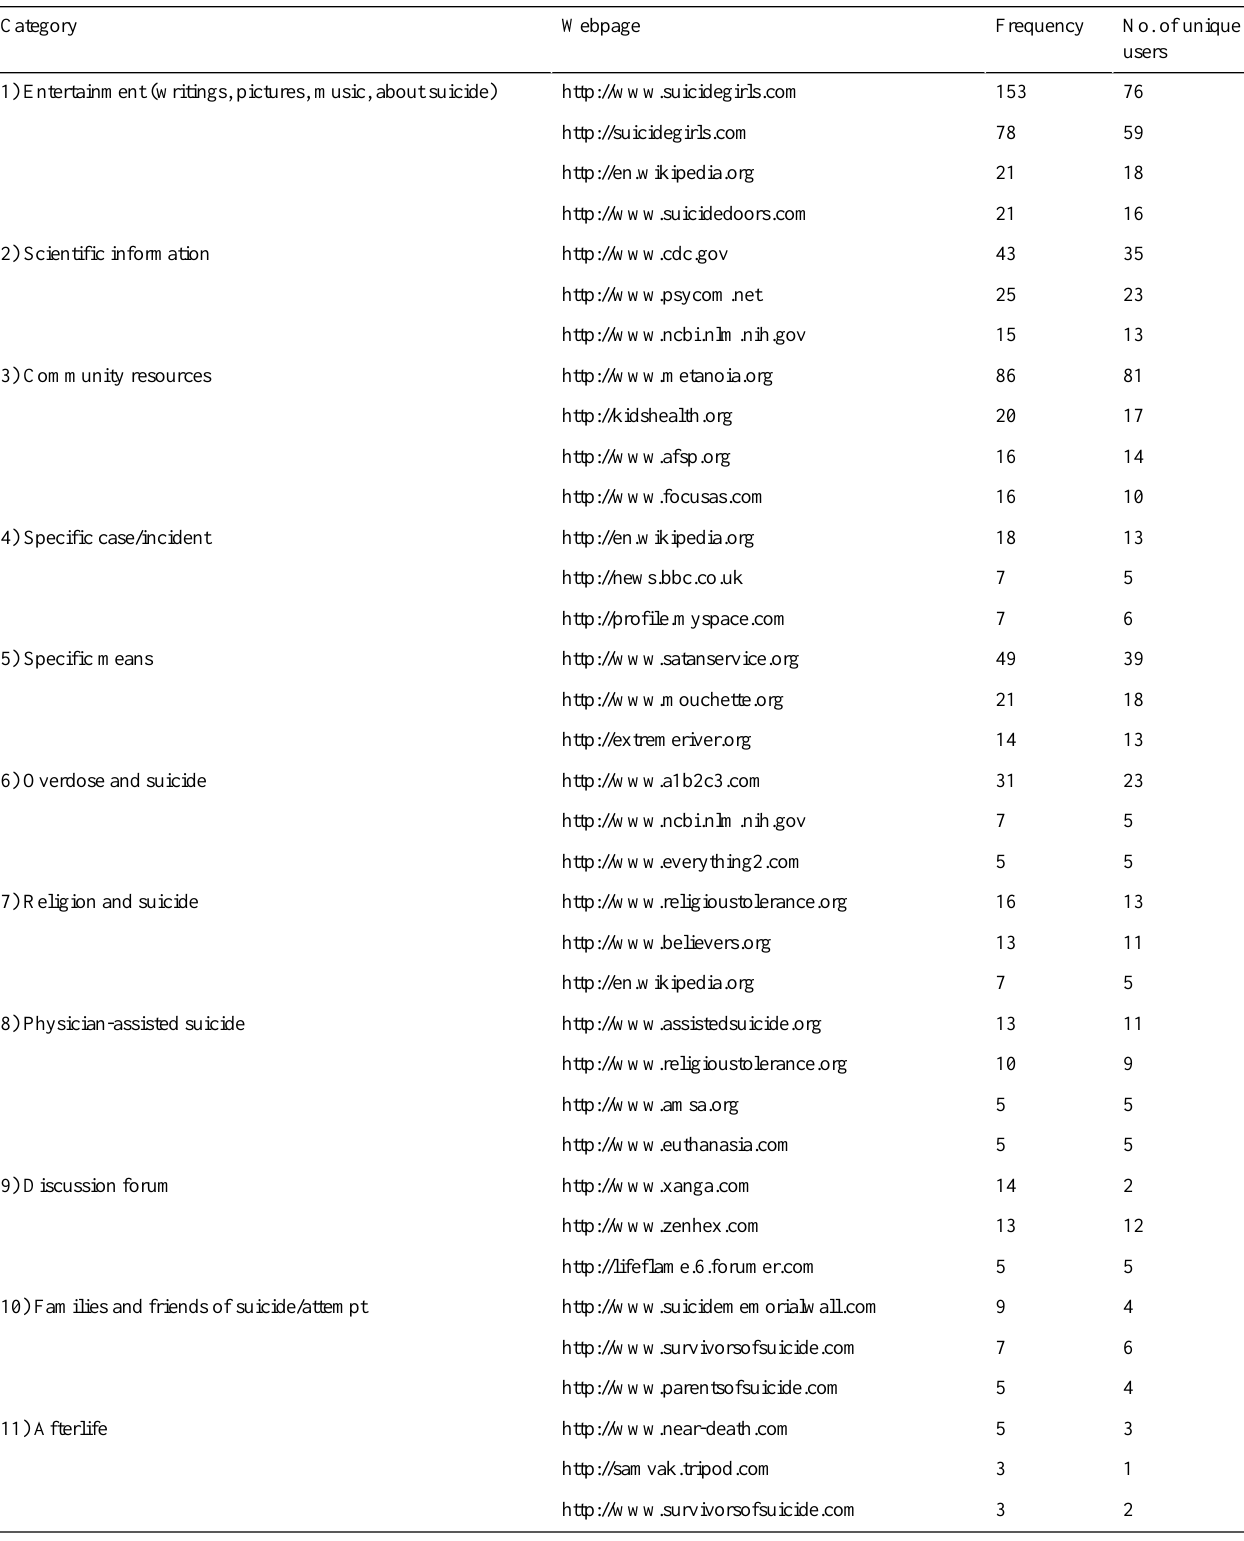
No. of unique usersFrequencyWebpageCategory